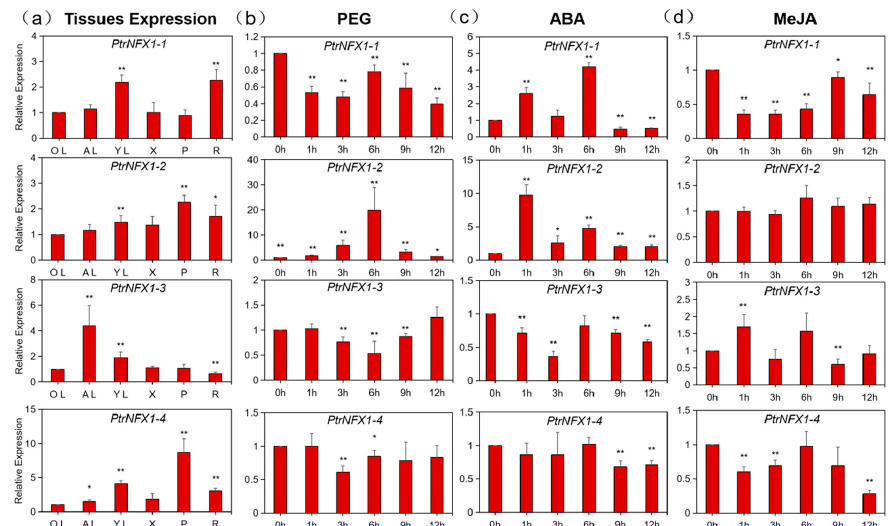
Figure 7. RT-qPCR analysis of the expression profile of PtrNF-X1 gene. ( a ) Transcript-level analysis of PtrNF-X1 in various tissues. YL, young leaf; AL, adult leaf; OL, old leaf; P, phloem; X, xylem; R, root. Transcript levels of PtrNF-X1 were measured by RT-qPCR in response to PEG treatment ( b ), ABA treatment ( c ), and MeJA treatment ( d ). Values are means + SE ( n = 20). Asterisks represent significant differences: * p ≤ 0.05; ** p ≤ 0.01.